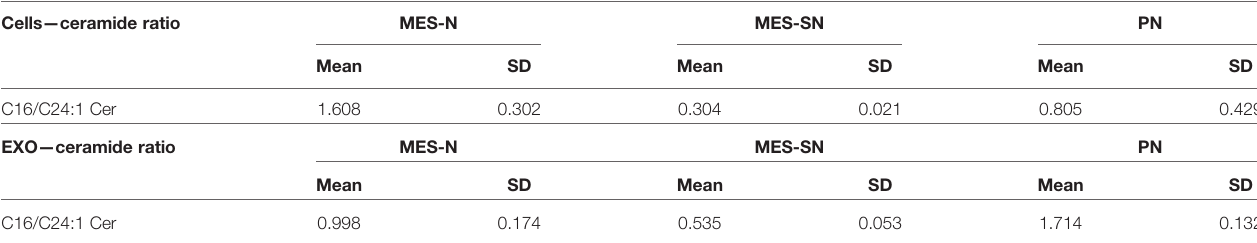
TABLE 3 | Ceramide ratios for cells and exosome phenotypes. Cells — ceramide